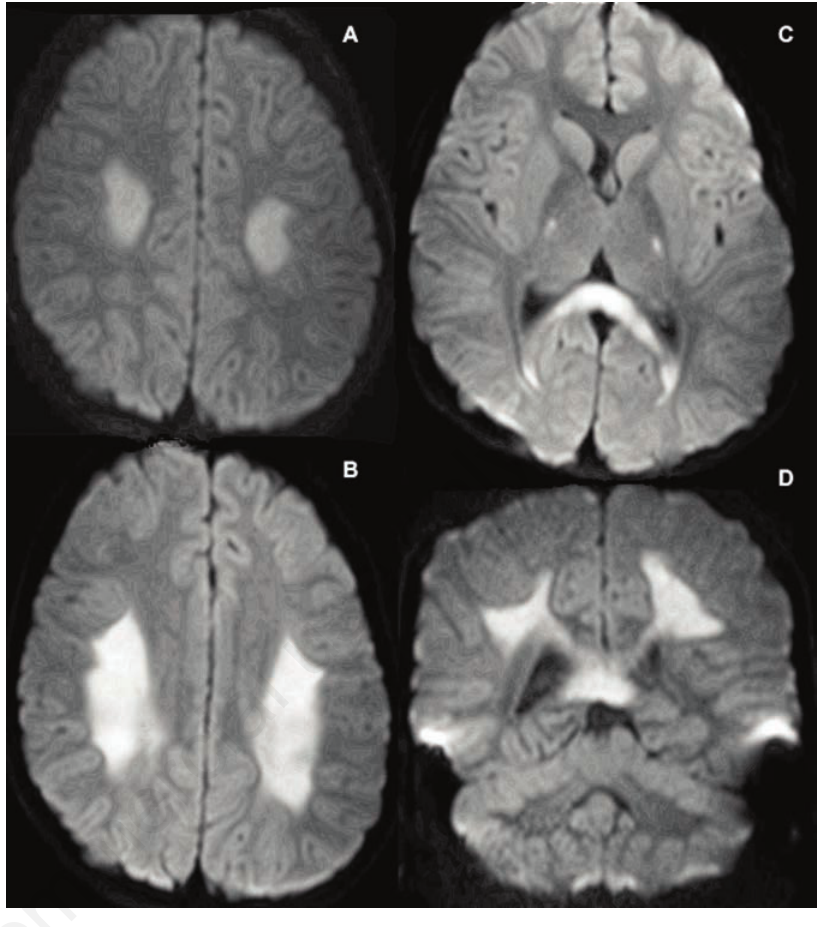
Figure 1. Brain magnetic resonance imaging (MRI) with diffusion-weighted images (DWI) shows the presence of high signals indicating lesions in the bilateral cerebral deep white matter (axial) alone in the first episode (A) and in the cerebral deep white matter (B; axial), at the splenium of the corpus callosum (SCC) (C; axial), and both (D; coro- nal) in the second episode (D) of the elder twin (Patient 1). Follow-up brain MRIs per- formed 3 months later showed complete resolution of lesions in the SCC but the pres- ence of small remaining lesions in the deep white matter (data not shown).